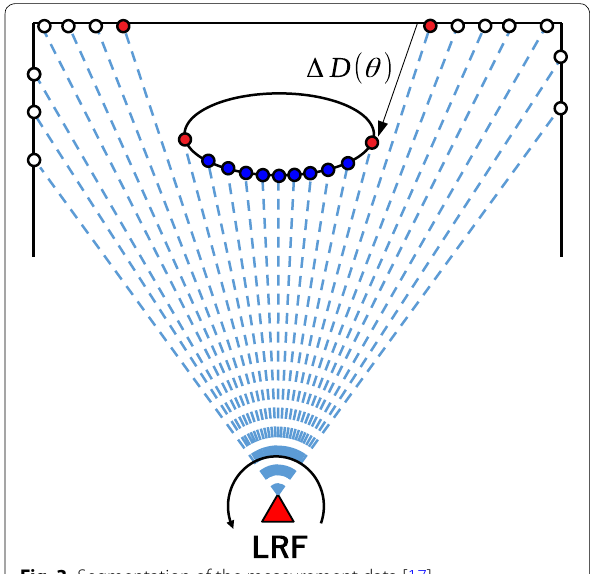
Fig. 3 Segmentation of the measurement data